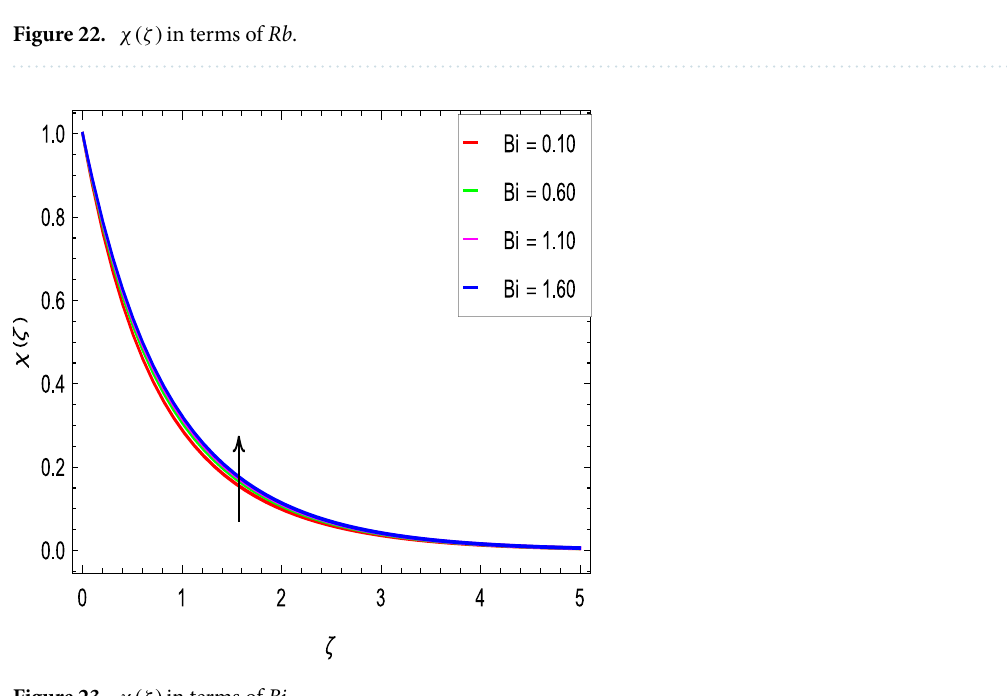
Figure 23. χ(ζ) in terms of Bi